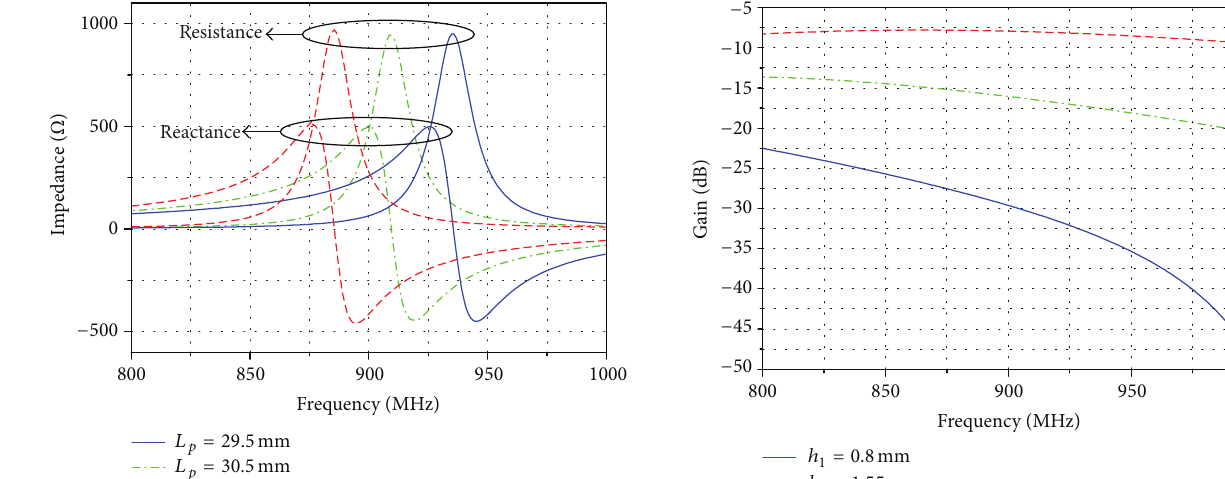
coupling between the transmission line and the patch and provides an extra parameter to match the antenna to the IC.